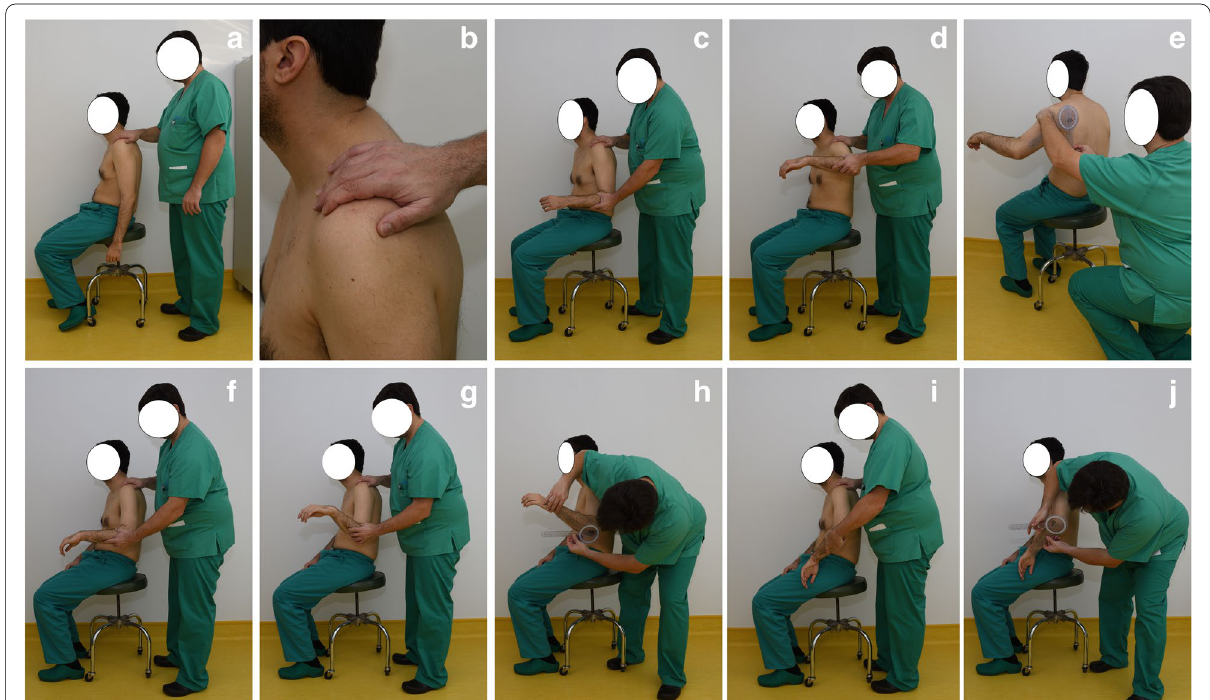
Fig. 1 The Glenohumeral ROM Assessment with Scapular Pinch (GRASP) method. For a detailed description of each image see